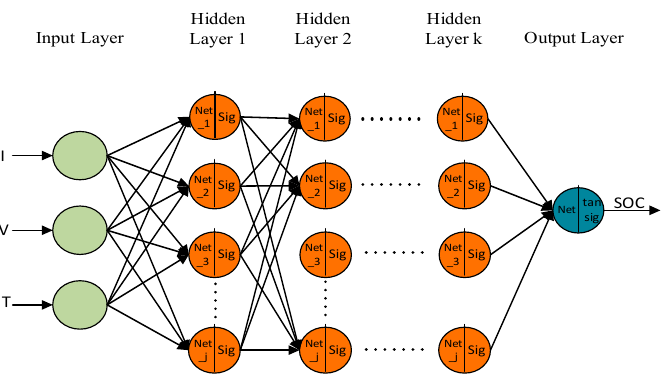
Figure 1. Artificial neural network (ANN) structure with three inputs, one output and multi hidden nodes.